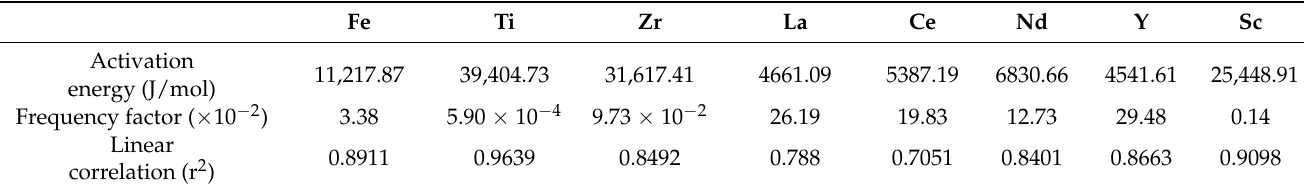
Table 6. Arrhenius data for the leaching of iron, zirconium, lanthanum, cerium, neodymium, yttrium, and scandium, varying the temperature. Experimental conditions: 100 mL of H 2 SO 4 4.0